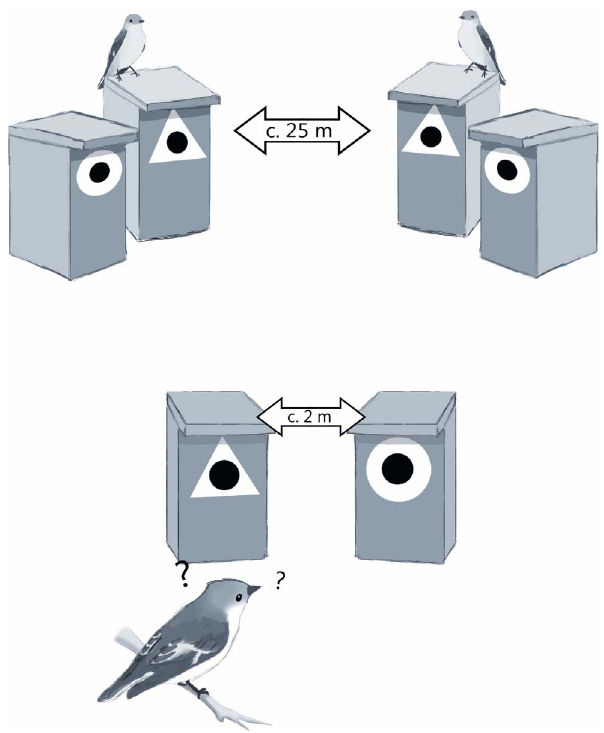
Figure 1. Experimental set-up. The first two flycatcher pairs were assigned to breed in a symbol that portrays the apparent choice of all conspecifics on the area (here a triangle) with an adjacent empty box with the other symbol (here a circle). Later arriving birds had to make a choice in an empty box-pair portraying apparent preferred and rejected symbols. Each later pair was also assigned the same manipulation symbol, thus increasing the amount of tutors for subsequent birds.